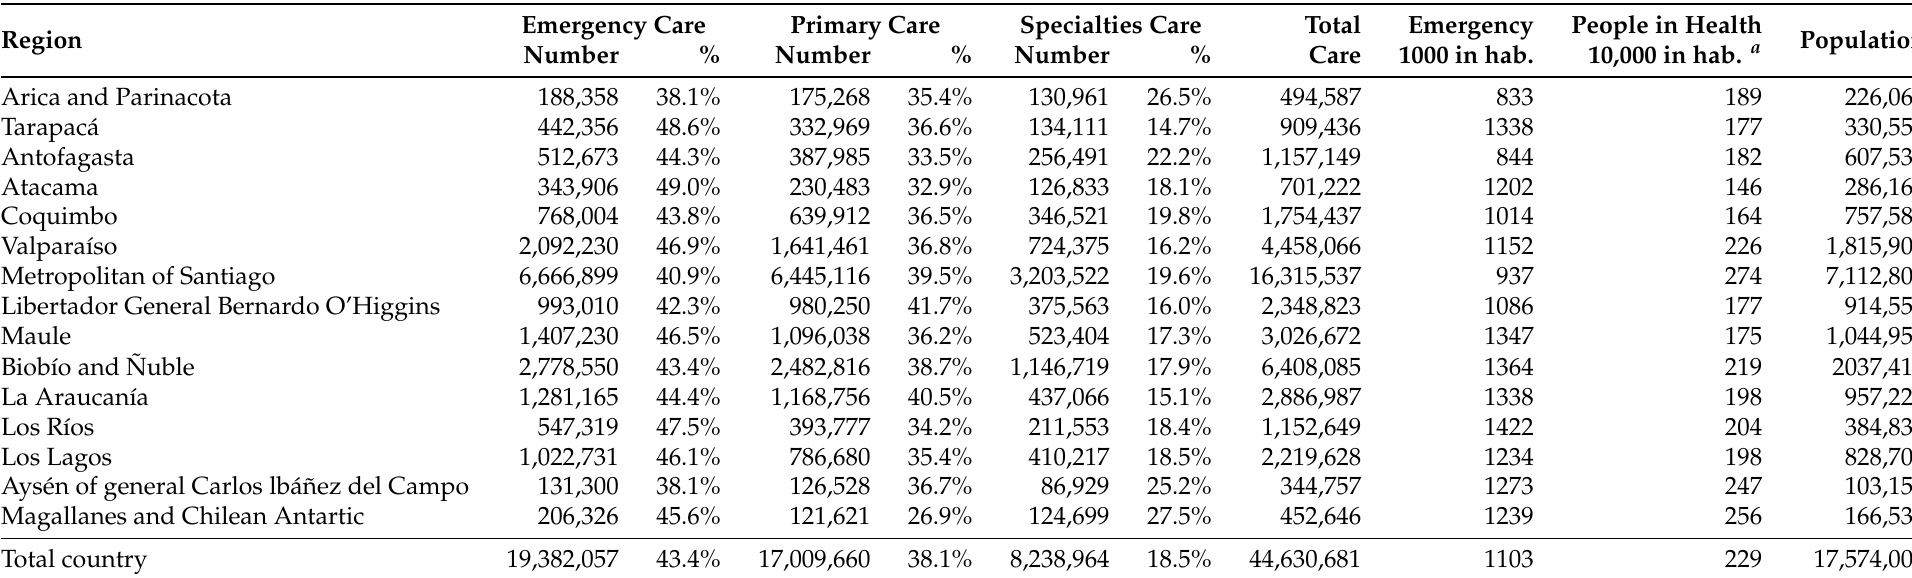
Table 1. Number of emergency, primary and specialty care attentions per Region in 2017 and population according to 2017 census. Emergency